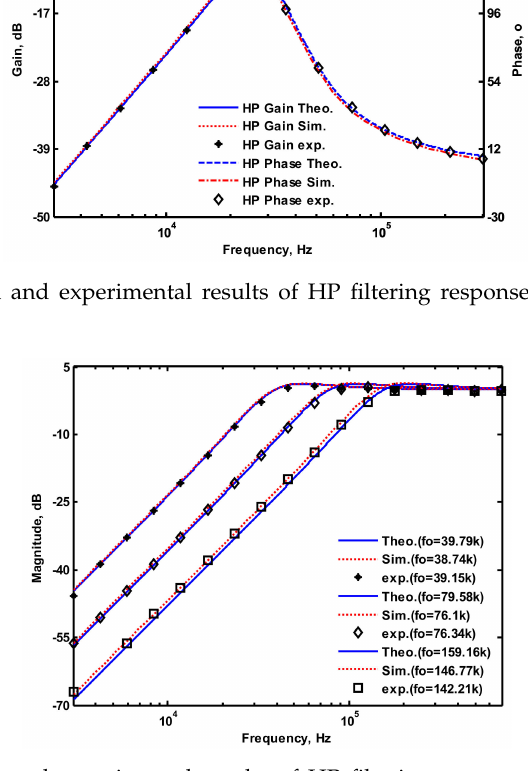
Figure 12. Simulation and experimental results of HP filtering responses at V o3 when V i1 = 0 and V i2 = V in